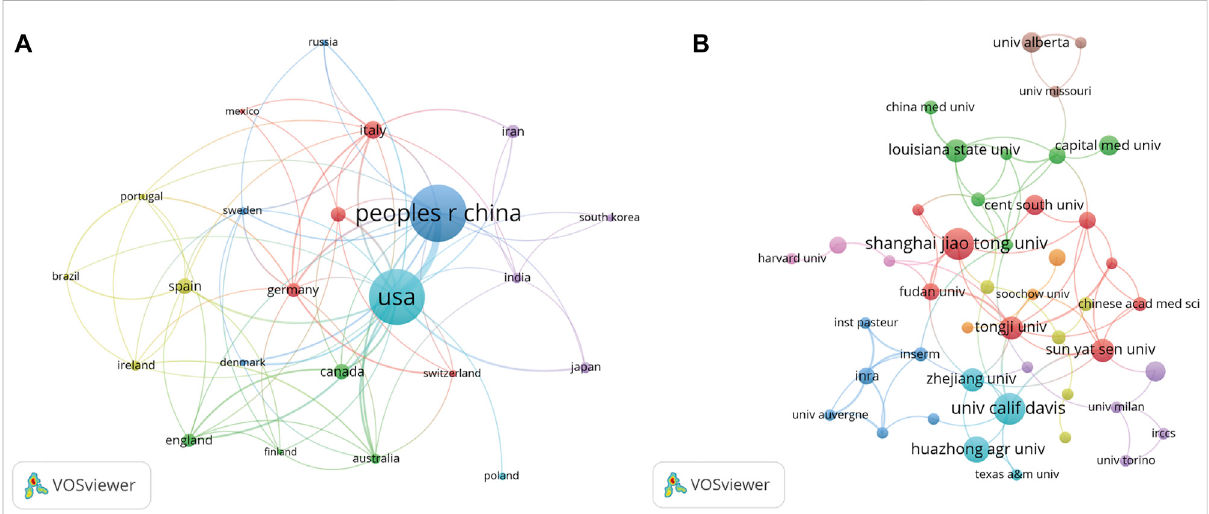
FIGURE 3 VOSviewer ’ snetworkanalysisofcountryandinstitutionco-authorship.Thewidthofthelinesrepresentsthestrengthoftheconnection. (A) The co-authorship analysis of countries with more than fi ve publications. (B) The co-authorship analysis of institutions with more than four publications.